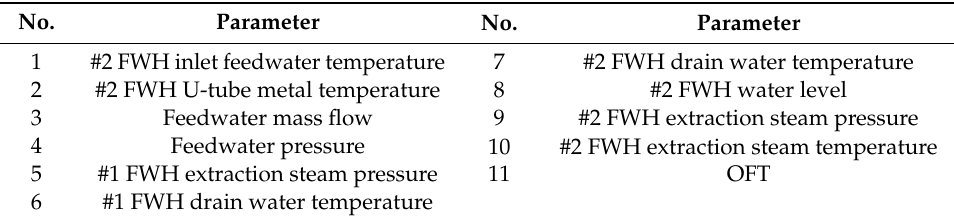
Table 1. Preliminary selection features for modeling